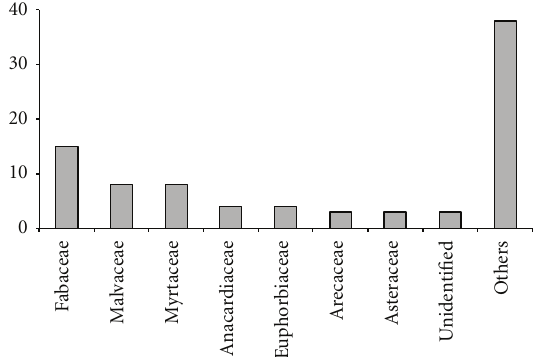
Figure 5: Number of species visited by Scaptotrigona a ff . depilis per plant family during one year (March 2010 to February 2011) in the University